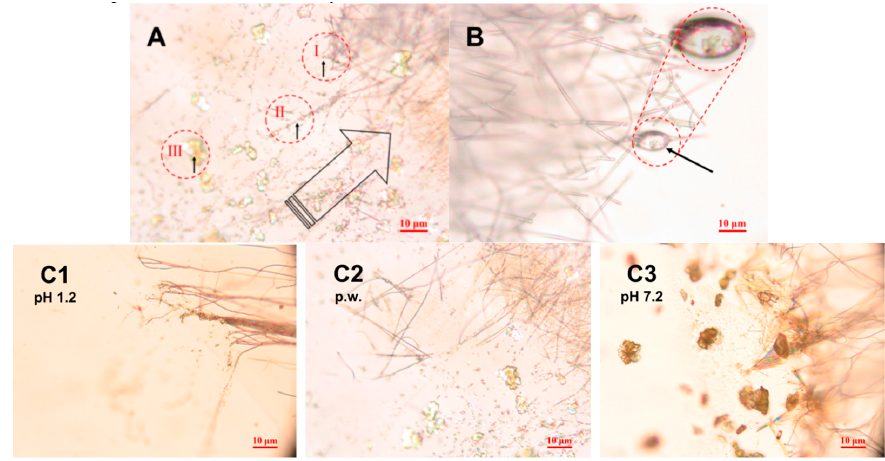
Figure 5. ( A ) Three phases identified in the release and crystallization of piroxicam (PRX) from hydroxylpropyl methylcellulose (HPMC) nanofibers. High-resolution light microscopy image (magnification 50×) validates the results obtained with SWLI (shown in Figure 6): I . PRX embedded in the nanofibers. II . Crystallization inside or on the nanofibers. III . Recrystallization of PRX. The large arrow indicates the propagation direction of the water front. Magnification 50×. ( B ) Representative micrograph on the initial dissolution of PRX–loaded polydextrose (PD) fibers. Visible crystals of PRX evident (highlighted with a black arrow) inside a red circle. Magnification 50×. ( C ) The PRX crystals visible at 30 s after wetting of nanofibers (HPMC:PRX 1:4) by placing a small drop of different dissolution media onto the surface of the fibrous sample: ( C1 ) hydrochloric acid buffer solution pH 1.2; ( C2 ) purified water, p.w. (pH 5.6); ( C3 ) phosphate buffer solution pH 7.2 (22 ± 2 ° C). Magnification 50×.